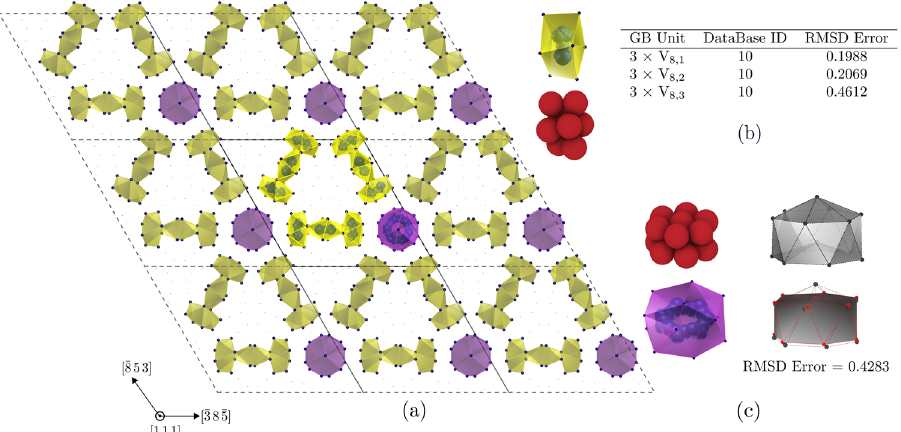
Fig. 5 The polyhedral unit model of the Σ 49(111) GB, as viewed along the twist-axis [111], is shown in a . The symmetric twist GB contains a network of screw dislocations. The core-region of the dislocation is described by the snub-disphenoid units and the atoms at the intersection of the screw dislocations are described by the 14-atom polyhedral unit. The smallest asymmetric unit (GB unit-cell) is shown and the polyhedral units in the unit-cell are highlighted. b The RMSD errors of the observed snub-disphenoids, when compared to the perfect unit, are shown. c The observed 14-atom polyhedral unit is minimized in LAMMPS and the relaxed structure is shown. Also shown are the two units superimposed on top of each other using the registration algorithm described in section S3.1. The planar primitive unit cell of the GB has been computed using the GBpy package (https://pypi.python.org/pypi/GBpy).